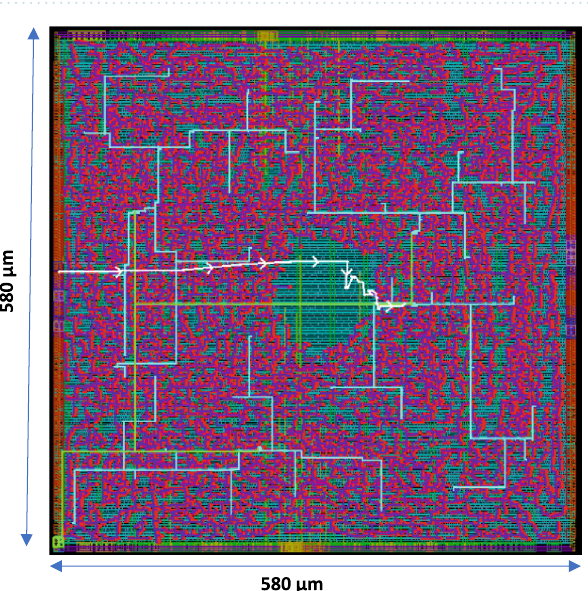
Figure 9. Sequential implementation for the digital hyperdimensional associative memory. The design includes the following modules: ( a ) array of memory cells (MC) of size 1 k × 10, where 1 k bits is the assumed vector dimension, and 10 is the number of stored classes. ( b ) An array of 1024 XOR gates, ( c ) a tree adder, and ( d ) a comparator.